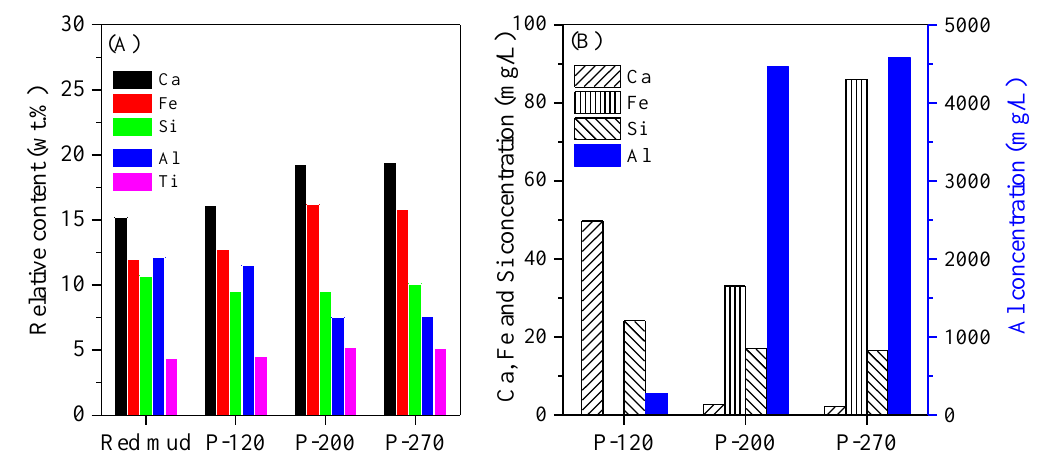
Figure 3. ( A ) Composition of red mud, P-120, P-200, and P-270, and ( B ) the major cationic concentrations in the supernatant after hydrothermal treatment.